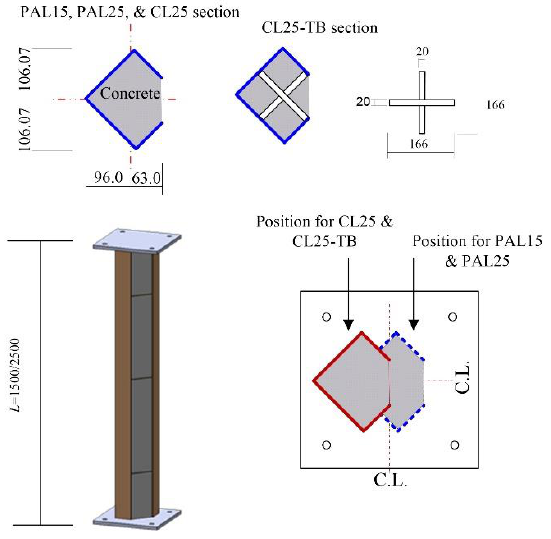
Figure 4. Schematic view of test specimens (unit: mm).